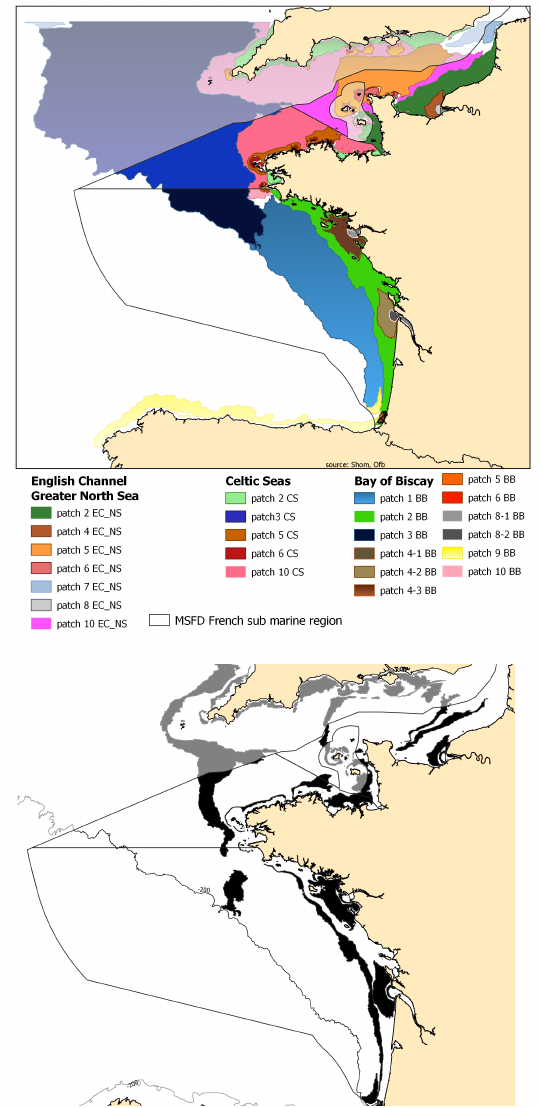
Figure 7. ( a ) Seascapes resulting in the overlap between hydrographical patches and MSFD marine sub-regions. The nomenclature of the patch name reveals its hydrographic specificities by the patch number (e.g., 2) and its administrative affiliation: EC-NS (English Channel–North Sea), CS (Celtic Seas) and BB (Bay of Biscay) and ( b ) interface between median